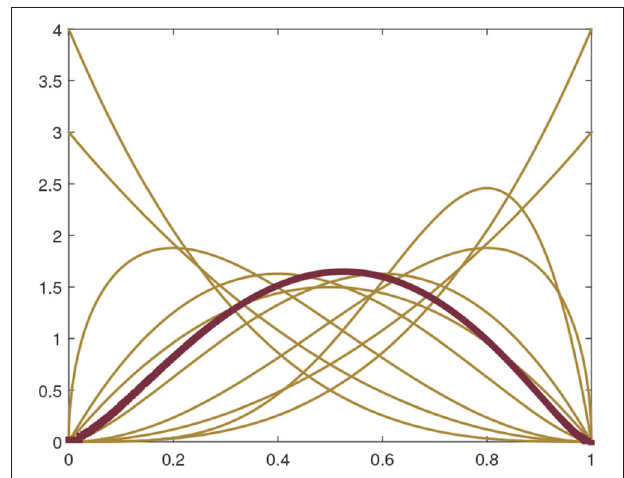
FIGURE 2 | Karcher mean of 10 Beta density